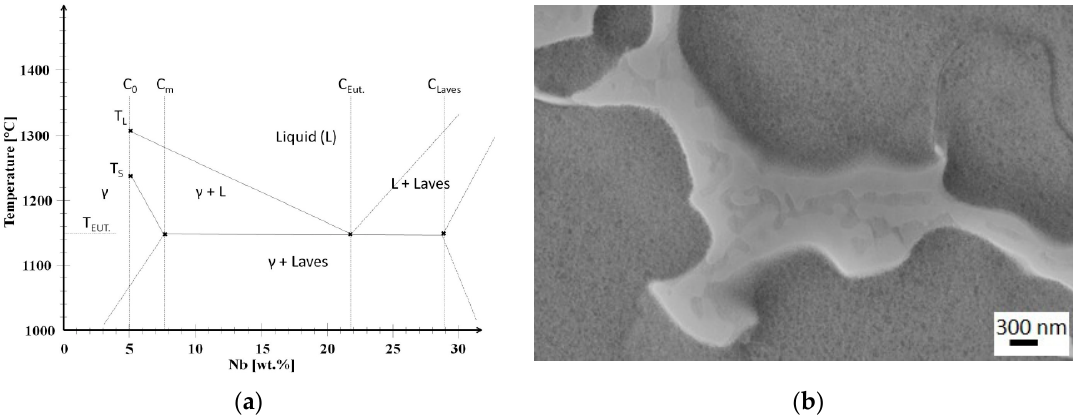
Figure 16. ( a ) Pseudo-binary phase diagram for alloy 718 [33] 1 and ( b ) eutectic Laves phase in FZ (mould NP). 1 Reproduced from [33], with permission from J. Andersson, 2021.